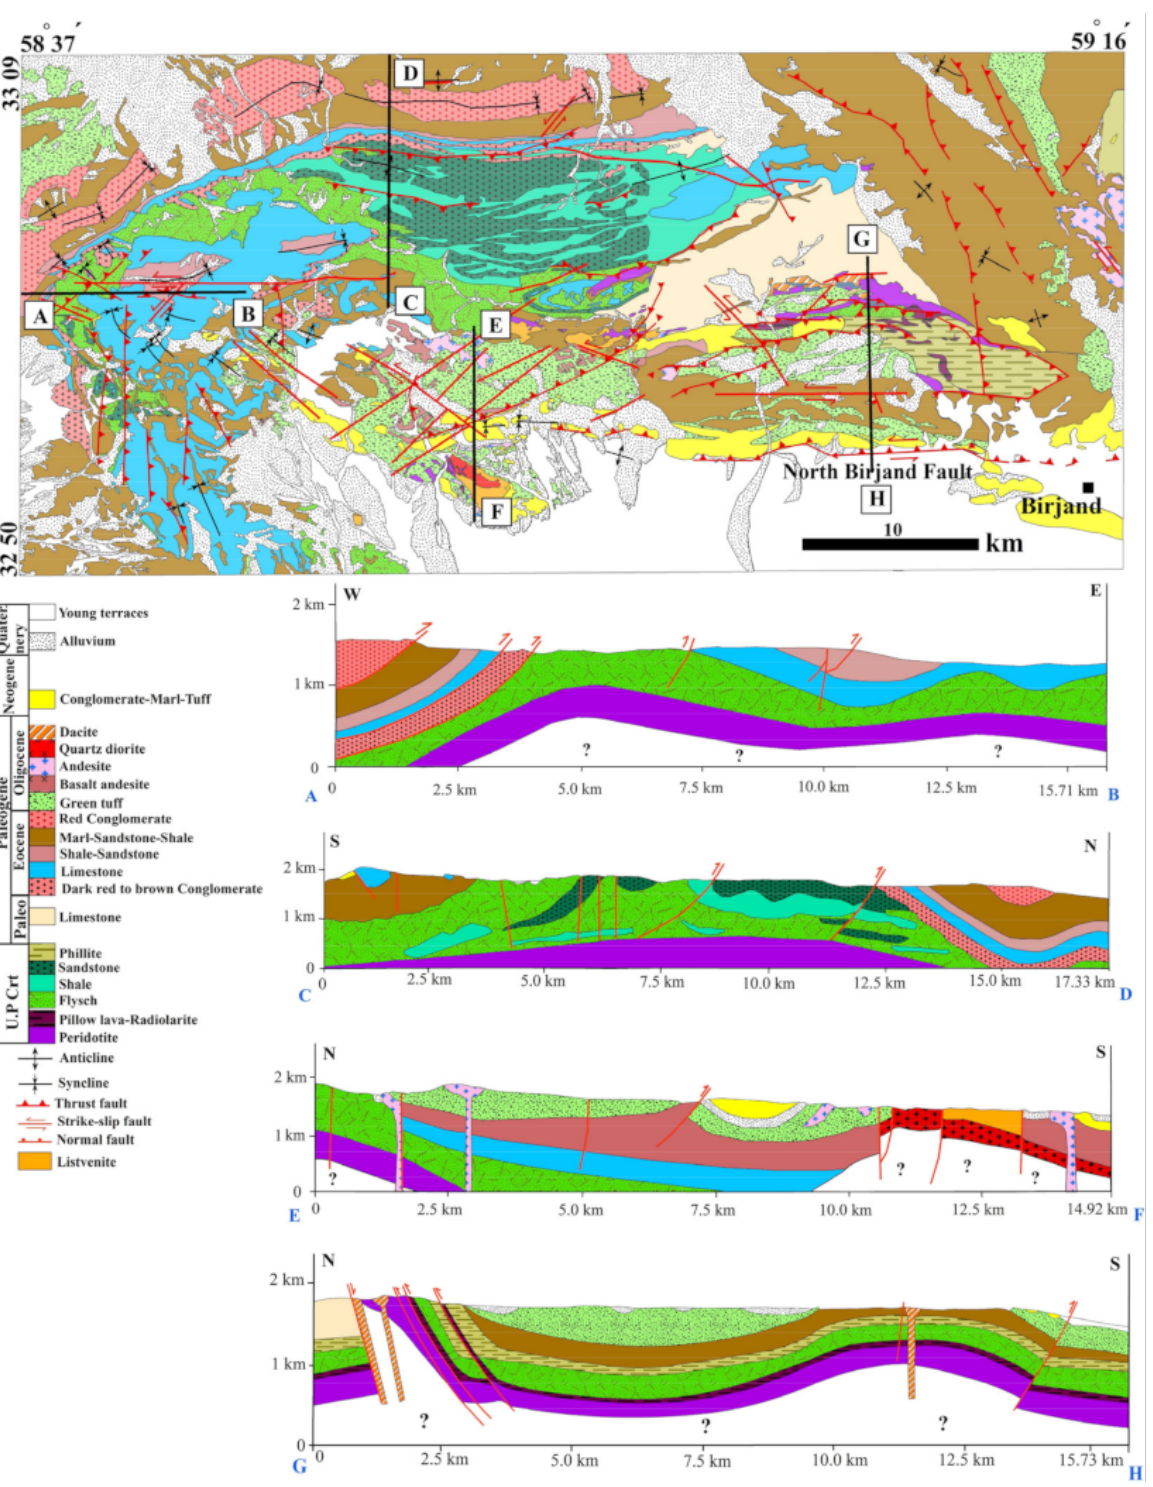
Figure 2. The research region’s geological map, modified after ref. [37], and four geological cross- sections. A-B, C-D, E-F, and G-H are profiles which show their cross-sections on the below part of the